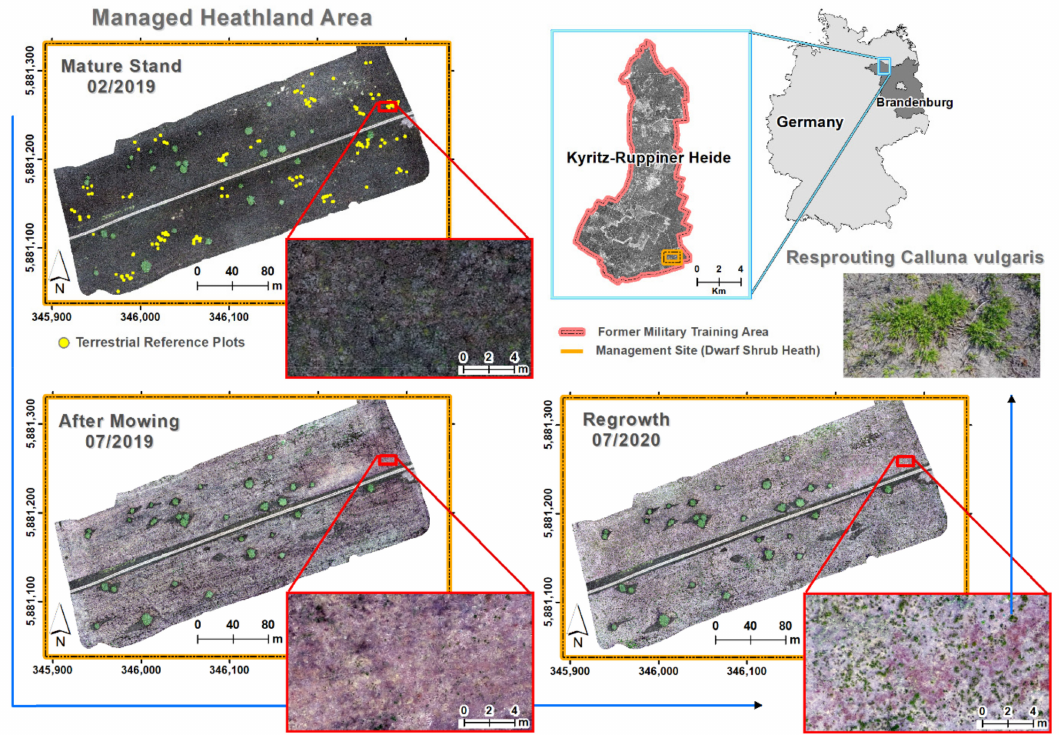
Figure 1. Location of Calluna Heathland test site before and after mowing management; images are generated as red-green- blue true-color composites from drone flights in consecutive seasons; Calluna resprouting and associated plant species are mapped on reference plot samples in the